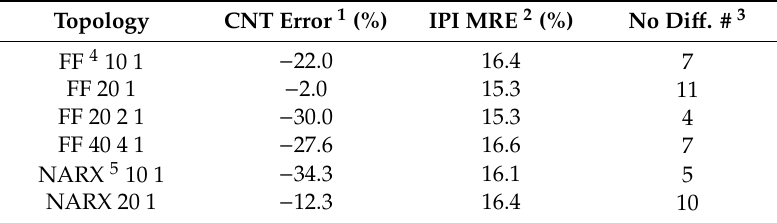
Table 1. Error metrics for the six different ANN topologies with reference to the ECG-derived number of heart beats and inter-pulse intervals.